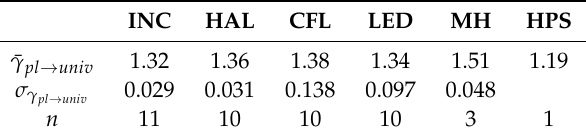
Table 8. The mean ( ¯ γ pl → univ ), standard deviation ( σ γ ), and sample size ( n ) of the photopic-to- pl → univ universal factor, by lighting technology. INC HAL CFL LED